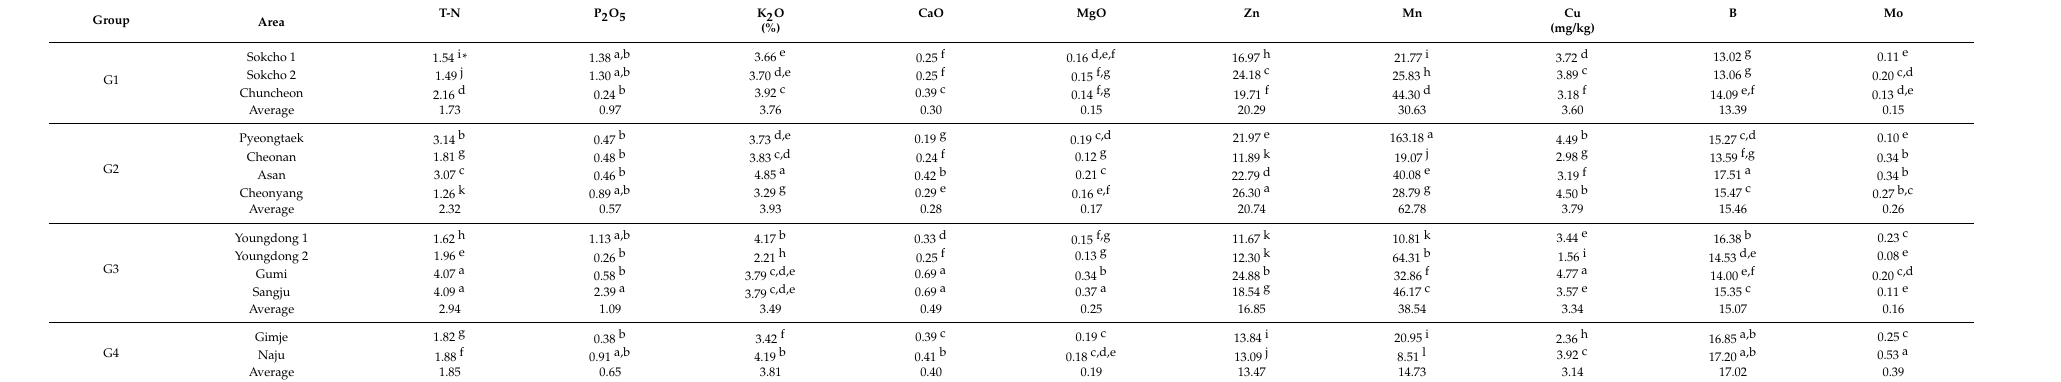
Table 10. Nutrient levels in plant at heading stage grown dehulled barley in different group areas in